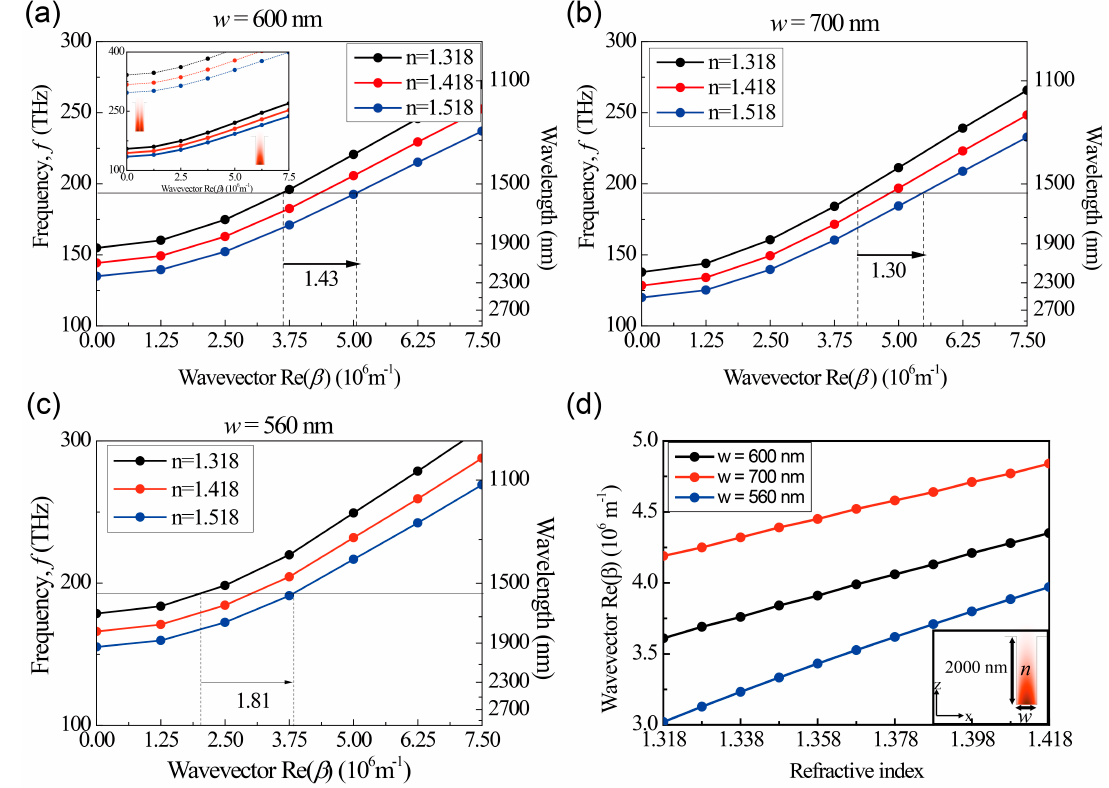
Figure 2. Dispersion curves of the plasmonic channel waveguide, filled with analytes of varying refractive index, for different waveguide widths of ( a ) 600 nm; ( b ) 700 nm; and ( c ) 560 nm; Inset of ( a ) shows the dispersion curves of the higher order mode which has one intensity node at the bottom of the waveguide. The electric field intensity mode profiles in the inset are obtained at the cut-off frequency of each mode. The incident wave is injected with a vacuum wavelength of λ 0 = 1550 nm. The propagation constant β is determined by the dispersion curves, affected by the width w and the analyte’s index n ; ( d ) Wavevector as a function of the refractive index of analyte for the three different waveguides with the widths of 560 nm (blue), 600 nm (black) and 700 nm (red). The inset shows a mode profile of the z-component of the electric field in the plasmonic channel waveguide with w = 600 nm and n = 1.318. The waveguide height h is set to 2 µ m to allow sufficient vertical confinement of light.